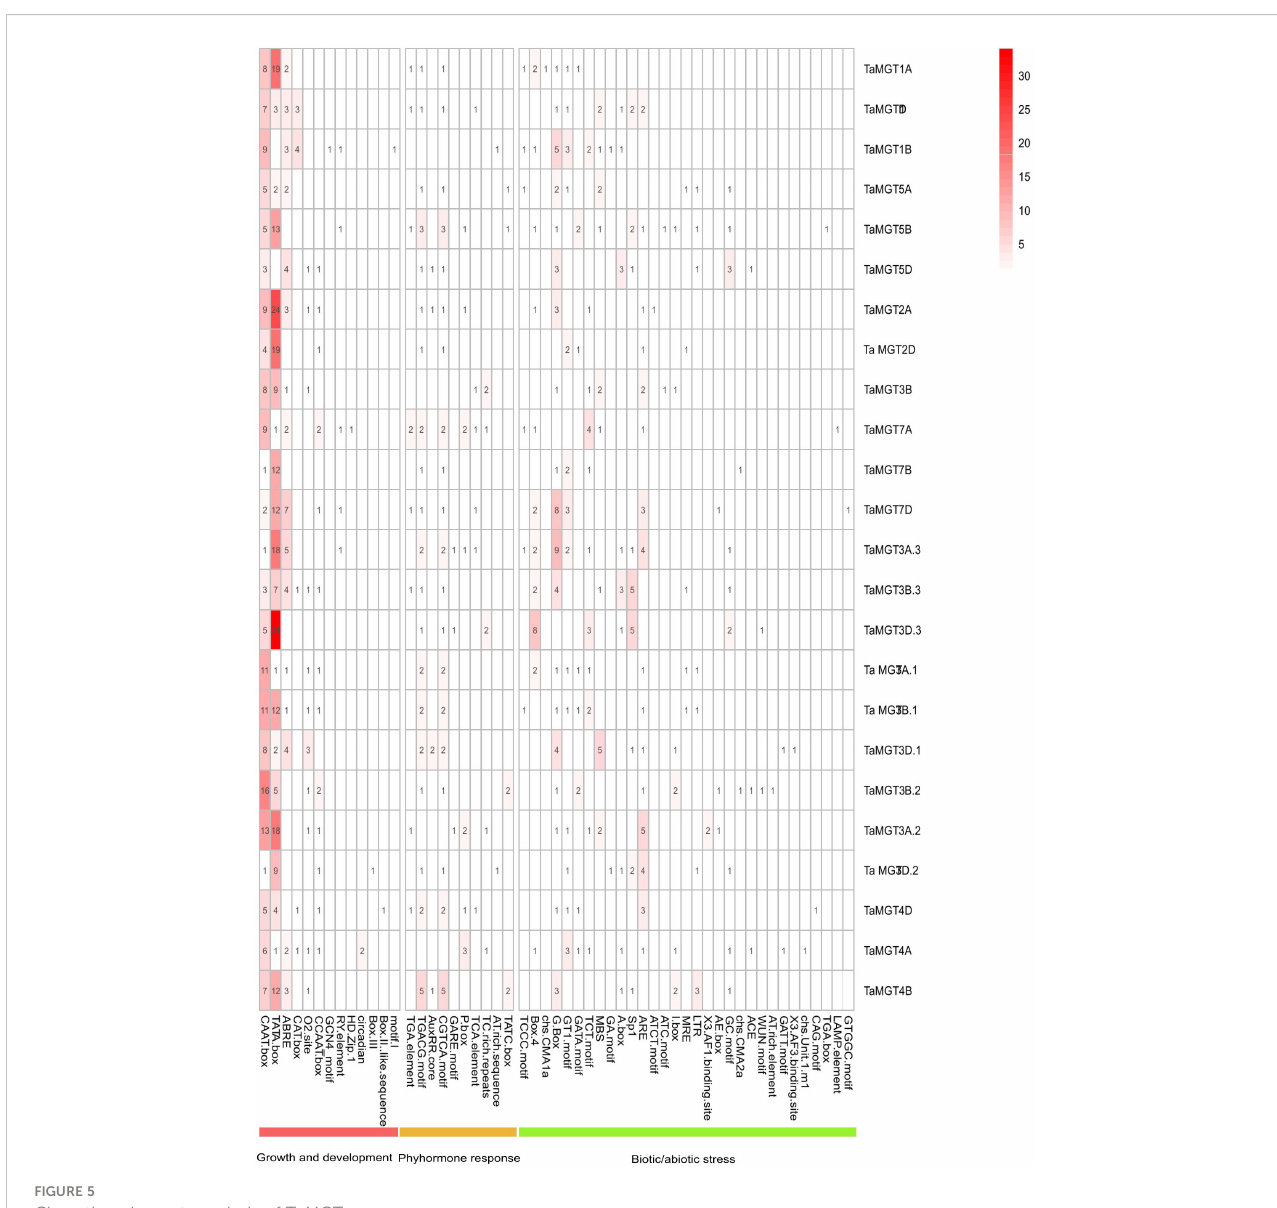
FIGURE 5 Cis-acting elements analysis of TaMGT